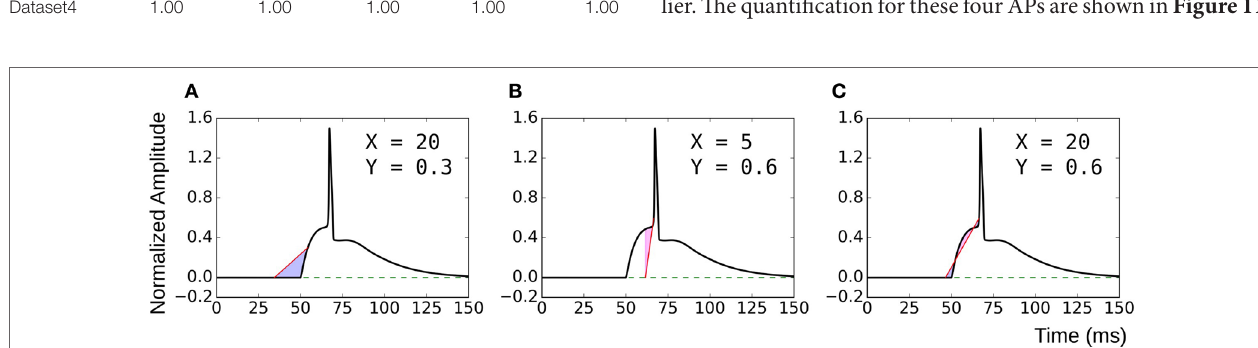
FIgURe 9 | Choice of parameters X and Y. (A) and (B) are examples of inappropriate choices of X and Y. (C) covers both the entire height and width of the AP foot and is consequently a good choice of parameter values.